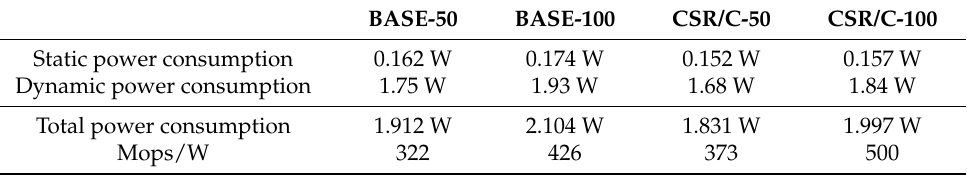
Table 3. The power efficiency of the baseline and CSR/C designs for 50 MHz and 100 MHz operating